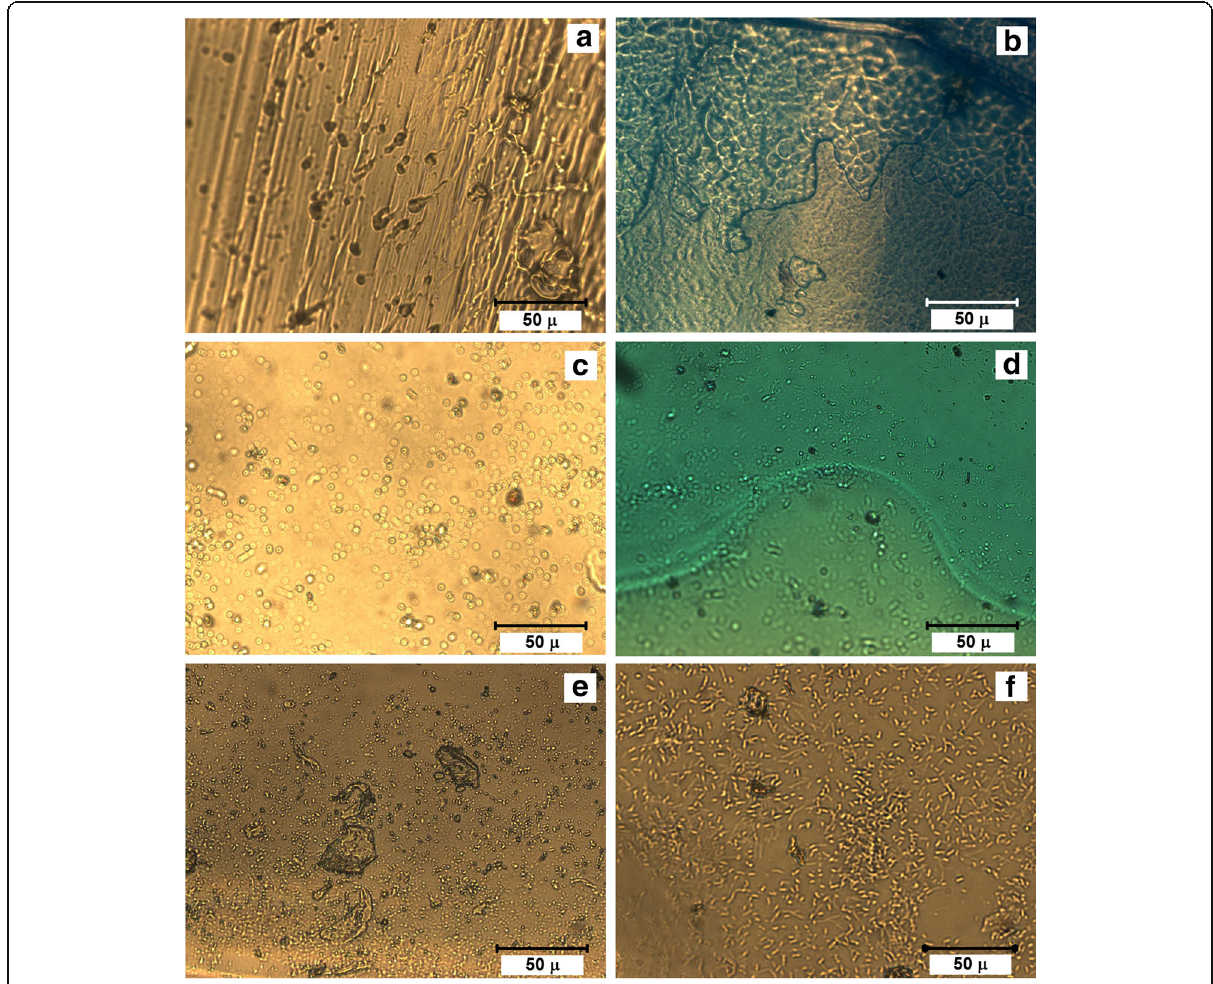
Fig. 1 LSM samples: PHEMA (No 10) — dry ( a ) and swollen ( b ); IPN PU/PHEMA (No 9) — dry ( c ) and swollen ( d ); and PU (No 8) — dry ( e ) and swollen ( f ). Methylene blue solution is used in the samples ( b ) and ( d ) for the image